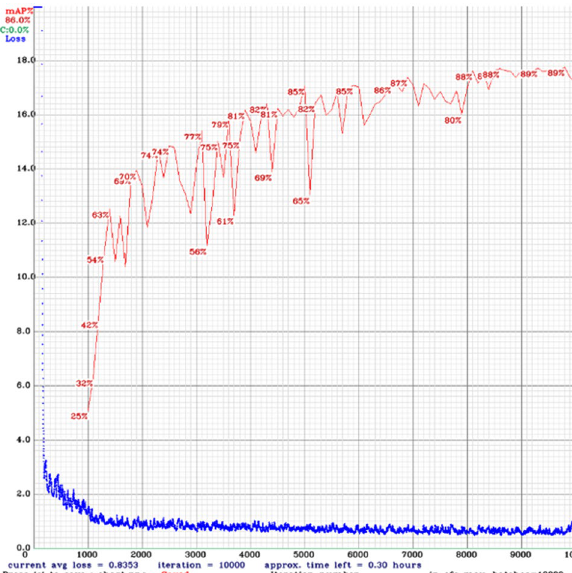
Figure 7. Training loss and mAP of SO-YOLO-2/256.